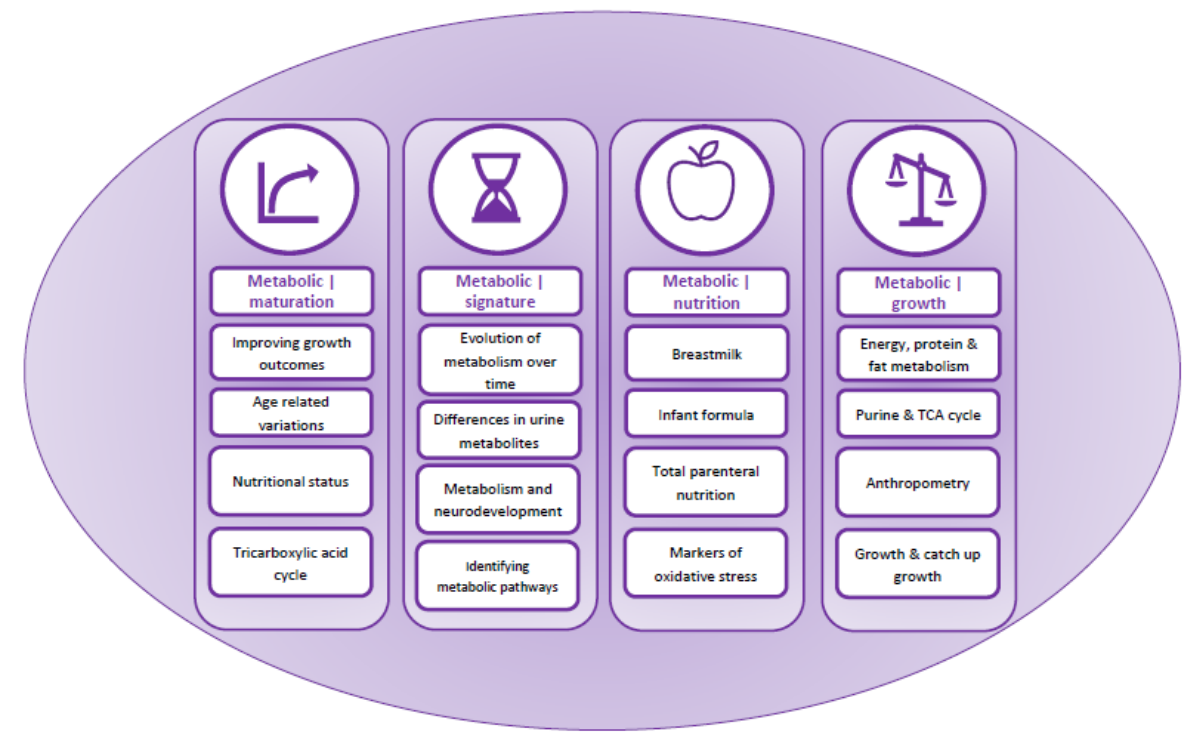
Figure 2. Graphical representation of the narrative synthesis and content analysis.